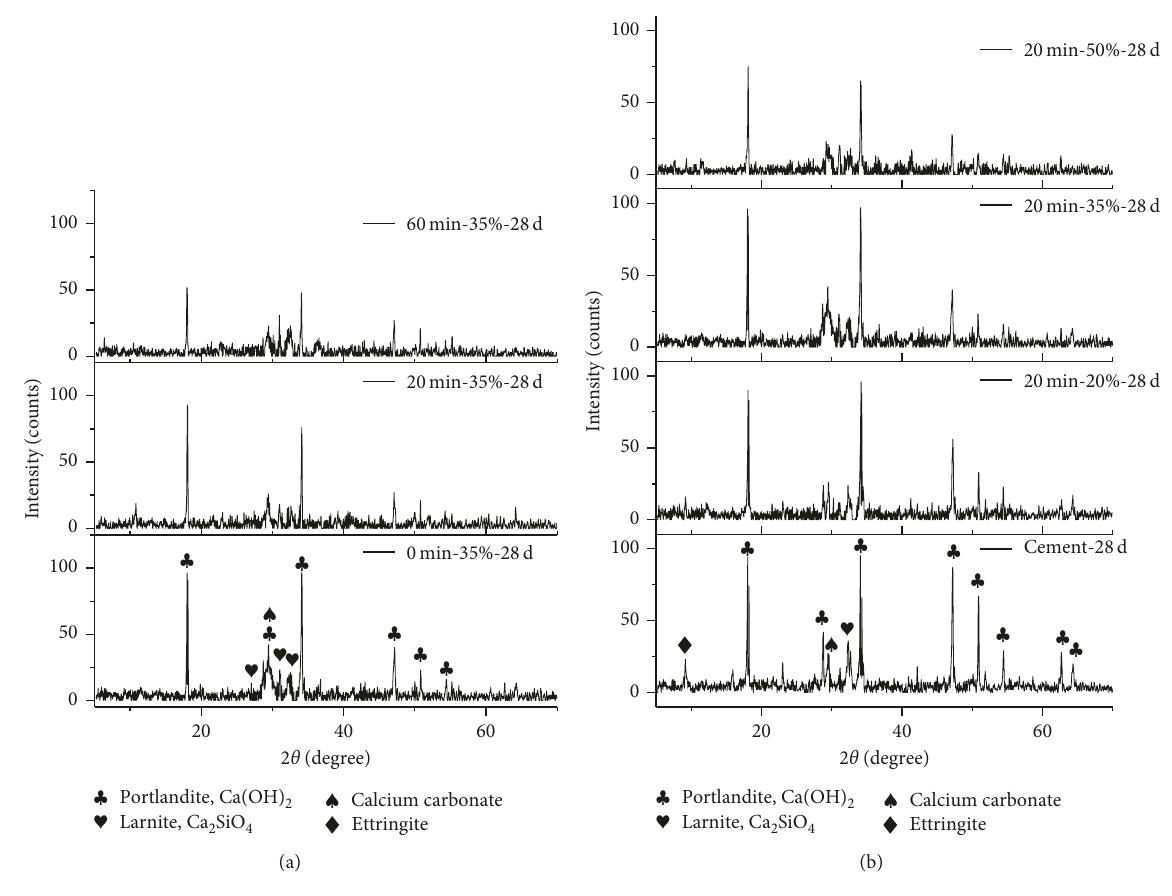
Figure 8: XRD of the specimens cured for 28